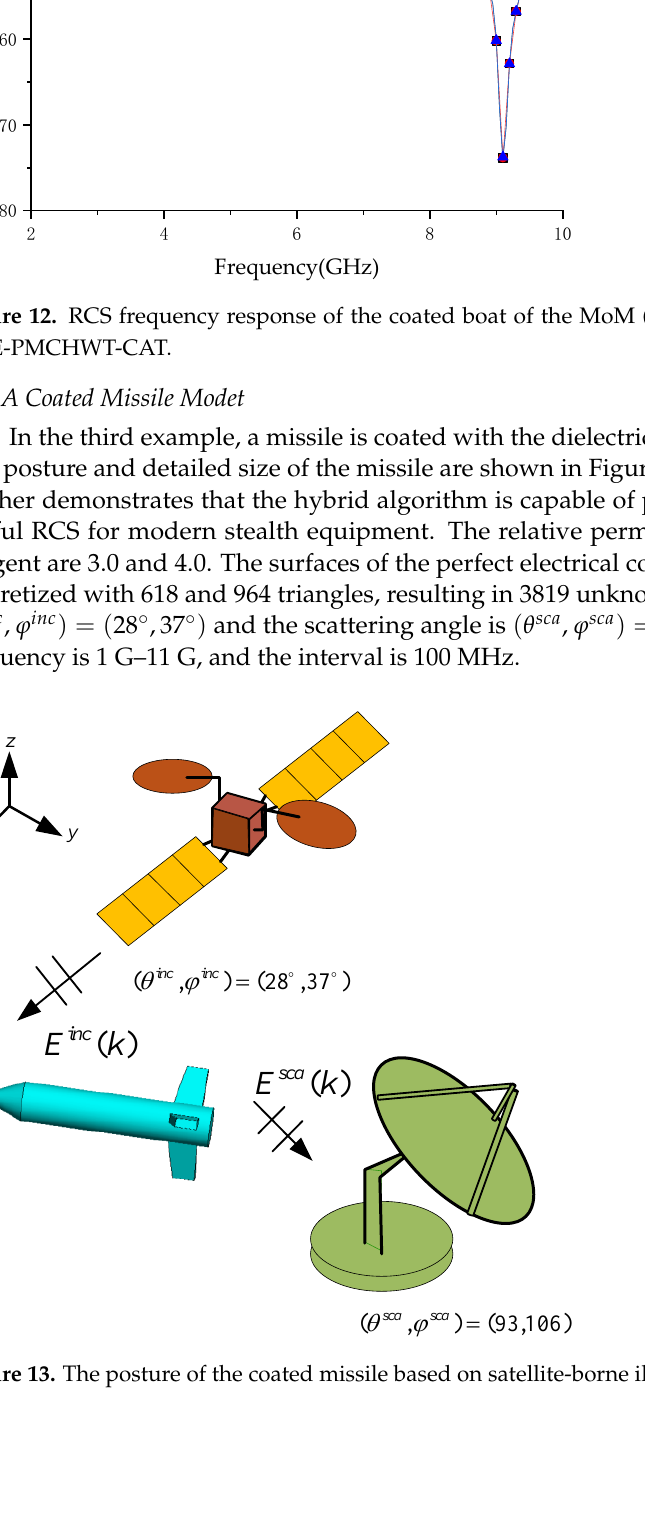
Figure 14. The geometry of the coated missile.